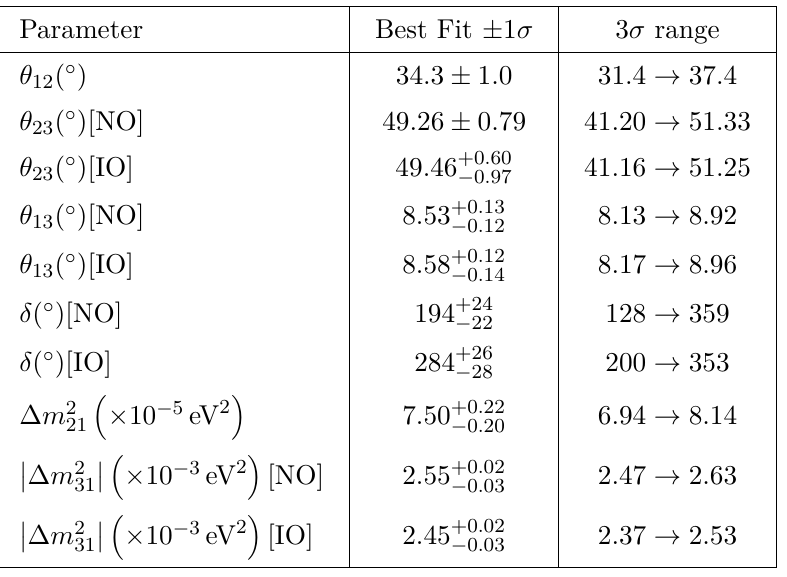
Table 2 . Current allowed intervals for the lepton mixing angles, neutrino mass-squared differences and the Dirac phase δ obtained from the global fit of neutrino oscillation data performed in ref. [4]. See also refs. [5] and